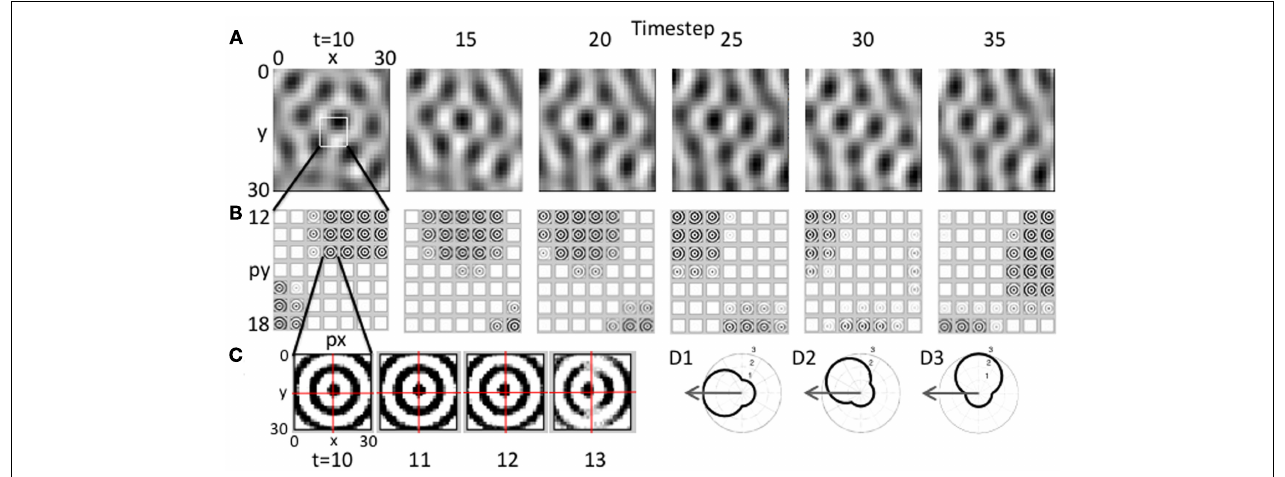
synaptic input. (C) Expansion of the synaptic input from the heading angle neurons coding a single spatial phase shows that on successive time steps 11–13 the circles show a distortion toward theWest. Rhythmic regulation of the network prevents activity during the period when the same heading angle input would distort the pattern toward the East. (D1) A polar plot shows the amplitude of response of a heading angle cell with an angle of 180˚ (West). The arrow shows how the input velocity causes a maximum change in amplitude (3.0) for this heading angle cell. (D2) A heading angle cell with angle of 135˚ (Northwest) has a smaller change in amplitude (2.4). (D3) A heading angle cell with angle of 90˚ (North) shows no change in response for this velocity, but maintains the background amplitude